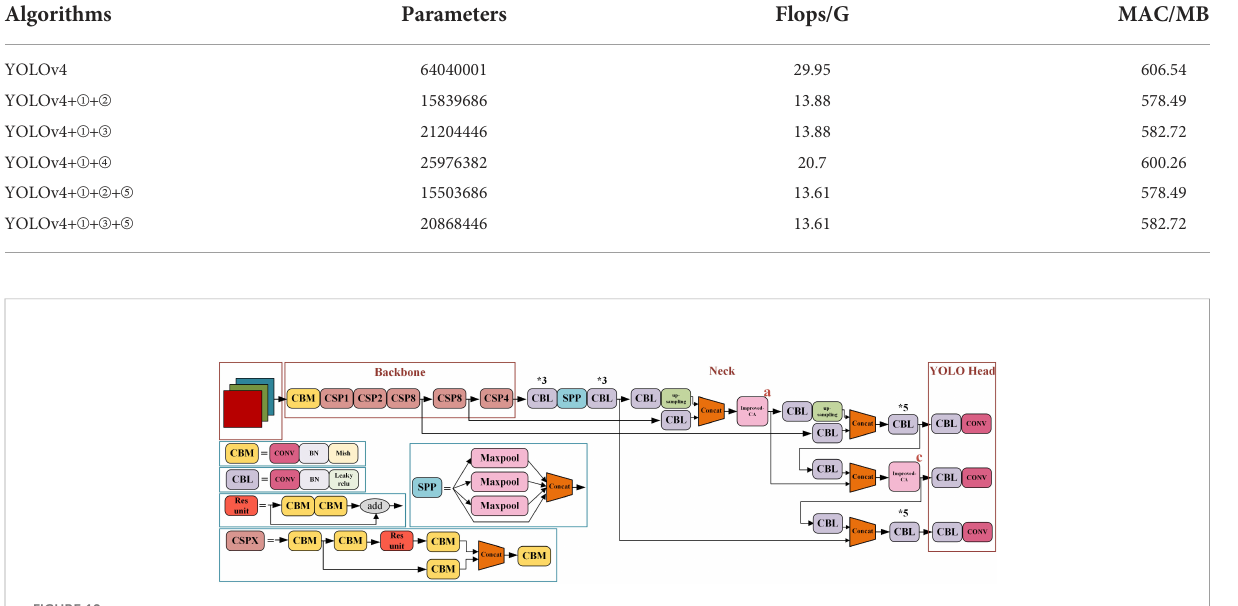
FIGURE 10 The improved YOLOv4 network structure diagram. * means repeat the operation.